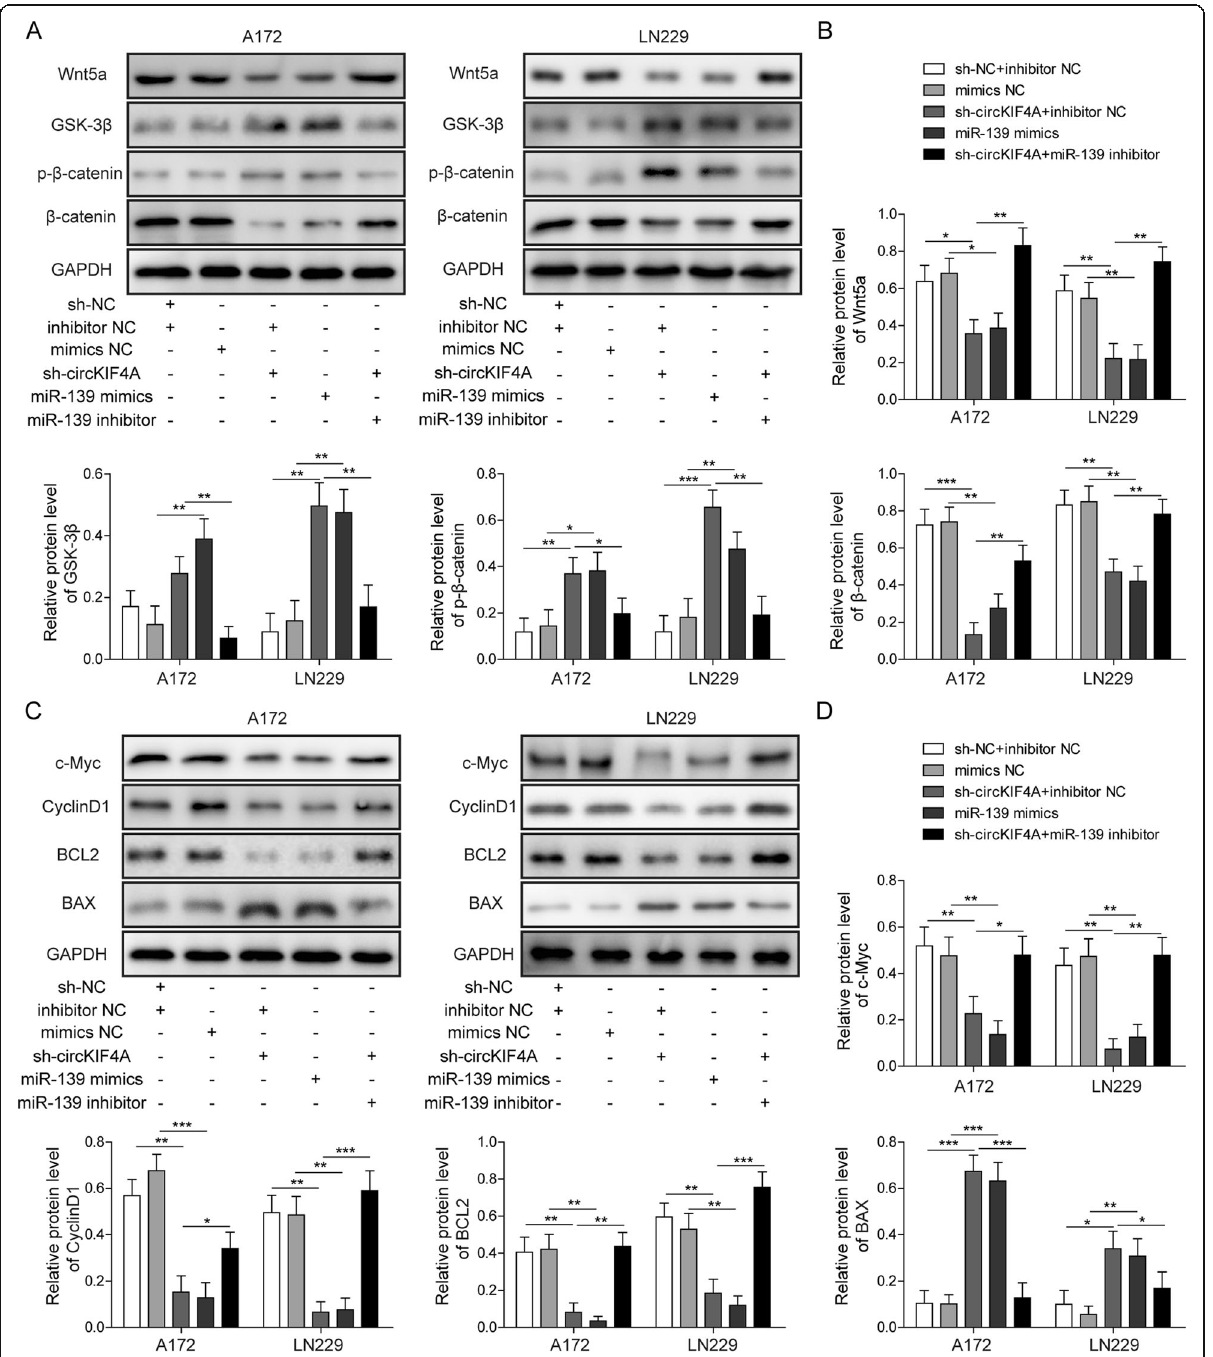
Fig. 5 circKIF4A knockdown inhibited the Wnt/ β -catenin signal pathway and regulated proliferation-related signal by targeting miR-139-3p. After transfecting A172 and LN229 cells with sh-circKIF4A, miR-139-3p mimics or miR-139-3p inhibitors, a the protein expression of Wnt5a, GSK-3 β , β - catenin and p- β -catenin were detected by Western blotting. b The quantification of Wnt5a, GSK-3 β , β -catenin and p- β -catenin relative protein level as a ratio to that of GAPDH (internal control). c The protein expression of c-Myc, cyclin D1, Bcl2 and Bax were detected by Western blotting. d The quantification of c-Myc, cyclin D1, Bcl2 and Bax relative protein level as a ratio to that of GAPDH (internal control). * p < 0.05, ** p < 0.01, *** p <